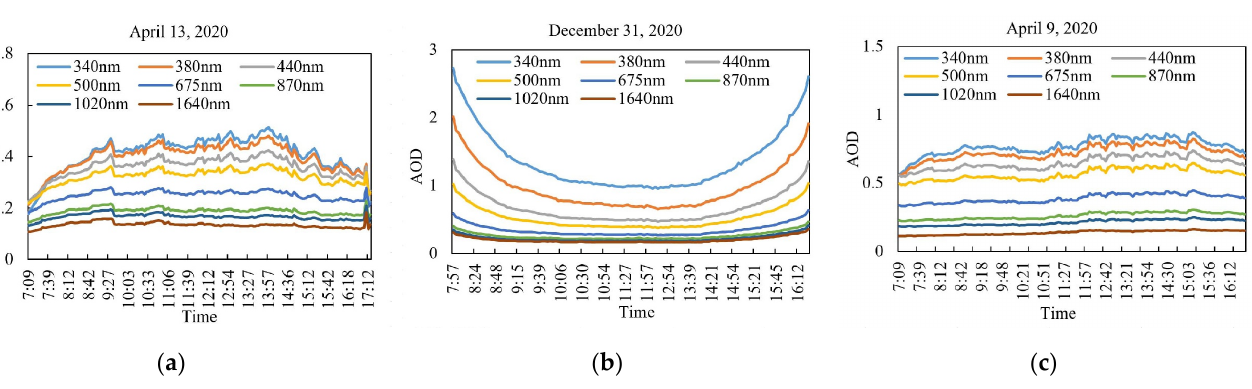
Figure 3. Diurnal variation of AOD in Shouxian. ( a ) Convex type. ( b ) Concave type. ( c ) Flat type.